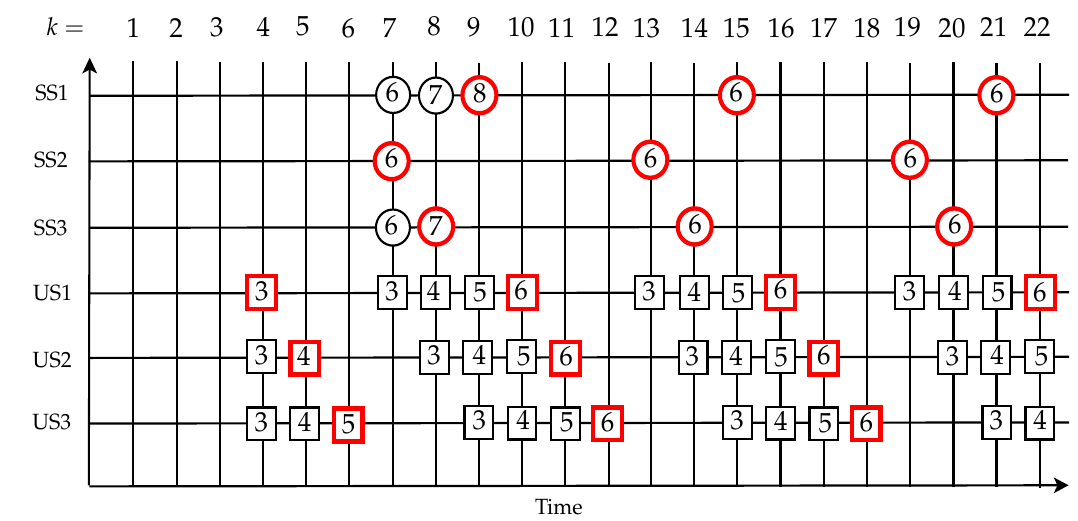
Figure 2. Sampling and scheduling patterns for an illustrative heterogeneous NCS of 3 stable (SS1, SS2, SS3) and 3 unstable (US1, US2, US3) sub-systems with AoI/AoI co-design architecture.